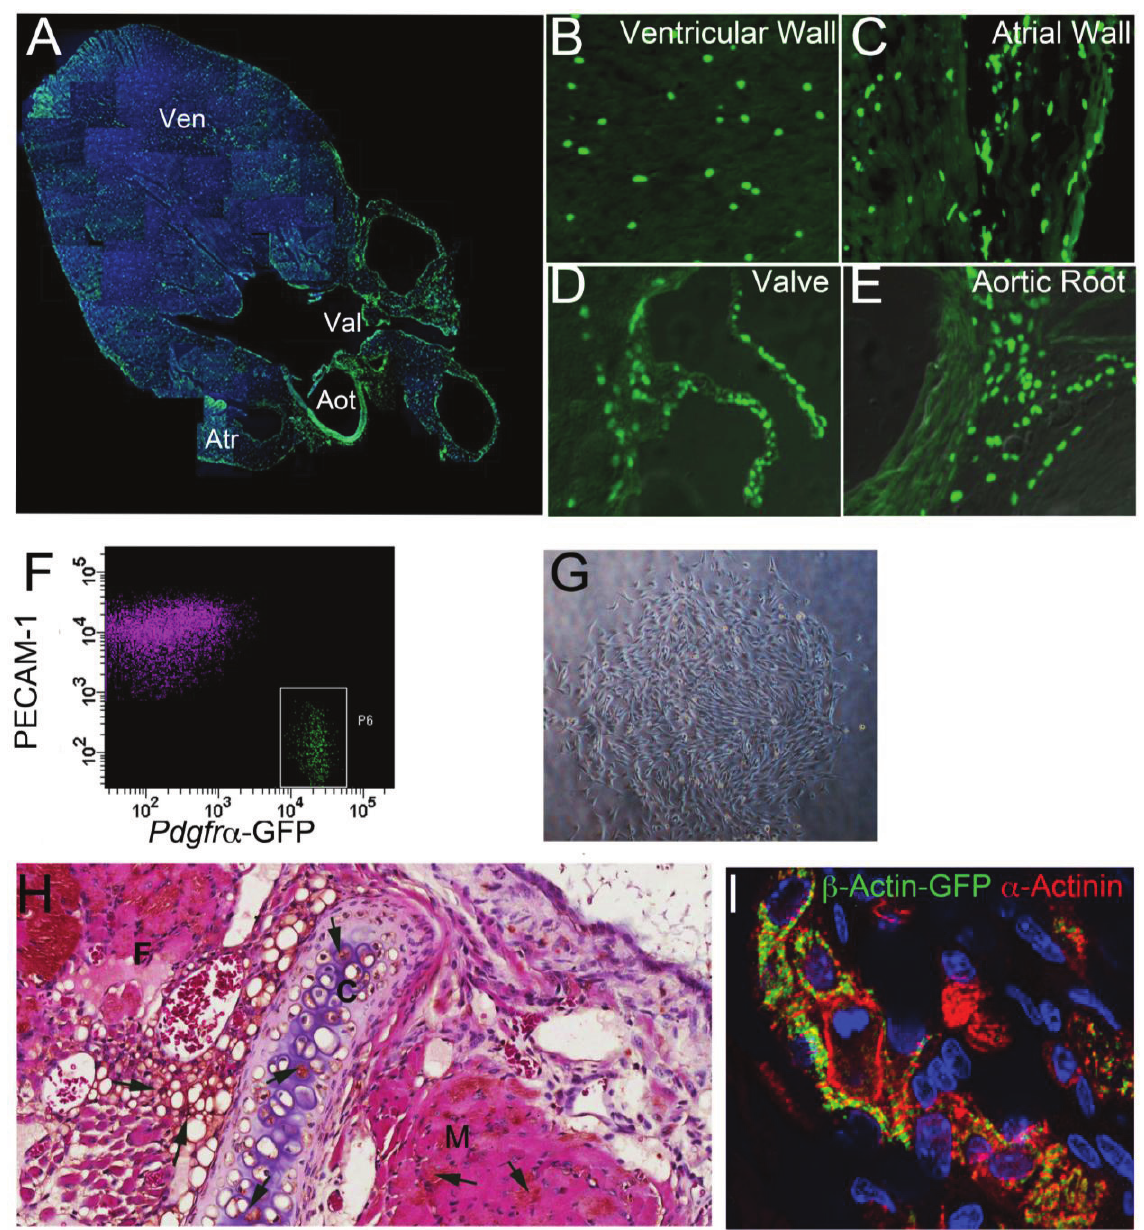
Figure 2. Platelet-derived growth factor receptor alpha is a marker of cardiac interstitial and perivascular fibroblasts and cardiac colony forming units-fibroblast (cCFU-F). ( A – E ) Cells exhibiting nuclear GFP fluorescence in Pdgfr (cid:3) - GFP knockin mice are distributed throughout the myocardial interstitium, valve leaflets and aortic root. Cardiac CFU-F cells are captured among the Sca1+/ Pdgfr (cid:3) - GFP+/PECAM1 − fraction on flow cytometry. ( F ) The figure shows the Sca1+ fraction segmented using GFP and PECAM1 antibody. ( G ) A representative large colony derived from the cardiac CFU-F fraction. ( H , I ) When cardiac mesenchymal stem/stromal cell (MSC)-like cultures are implanted under the kidney capsule with embryonic stem cells, they survive and differentiate into a range of mesodermal, endodermal and ectodermal lineages. Panels show fat (F), chondrocytes (C) and skeletal muscle (M) (brown histochemical staining for GFP, which marks cardiac MSC-derived cells, arrows) and cardiac muscle (GFP and cardiac alpha actinin